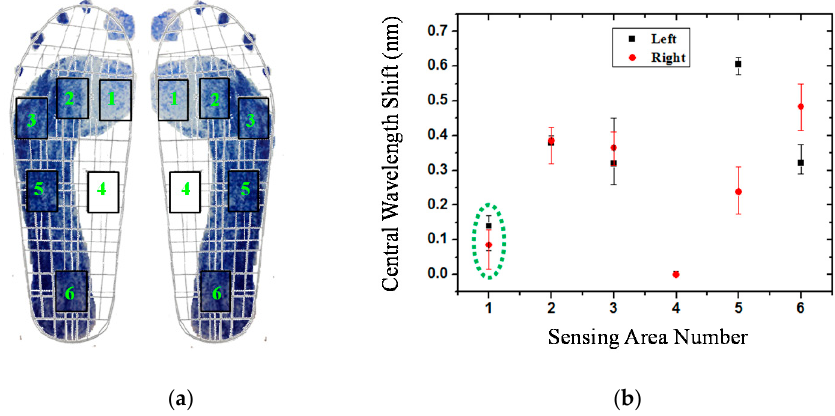
Figure 10. The plantar pressure distribution of supinated feet of participant No. 10: ( a ) Footprint; ( b ) central wavelength shift as a function of sensing area number.